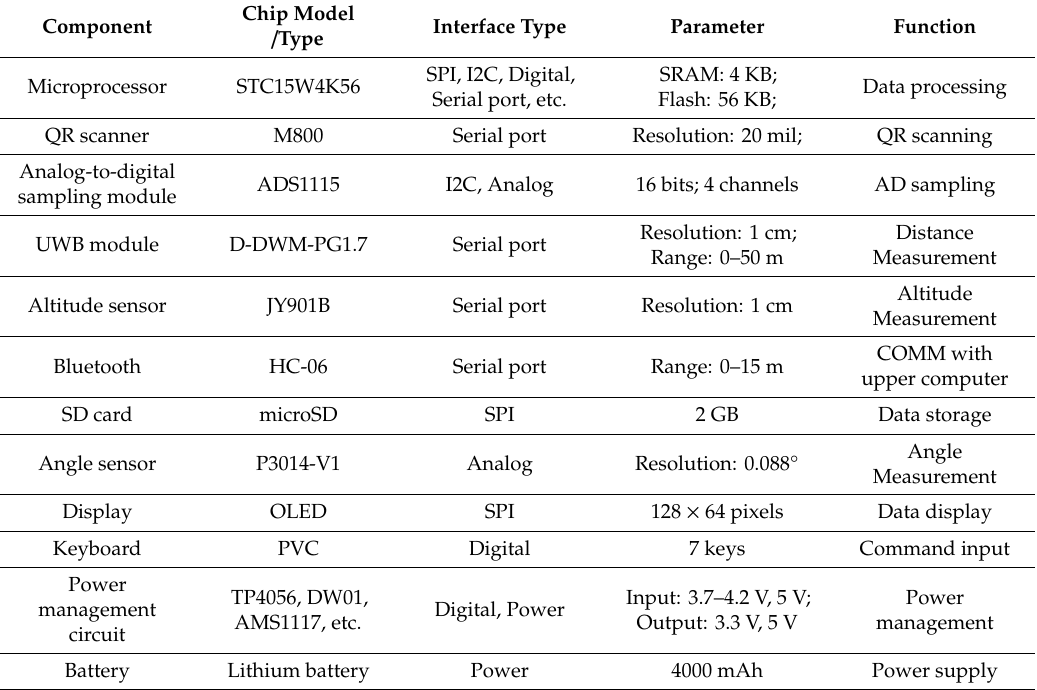
Figure 1. The main device and its components: 1, the left arm; 2, the middle beam; 3, the right arm; 4, the vertex; 5, the keys; 6, the display panel; 7, the flange; 8, the first angle sensor; 9, the battery; 10, the printed circuit board (PCB); and 11, the second angle sensor. Table 1. Descriptive statistics of the device's components 1 .